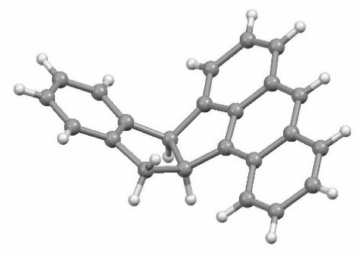
Figure 8. Molecular structure of indeno [1,2- α ]-10,16-dihydroaceanthrylene, 12